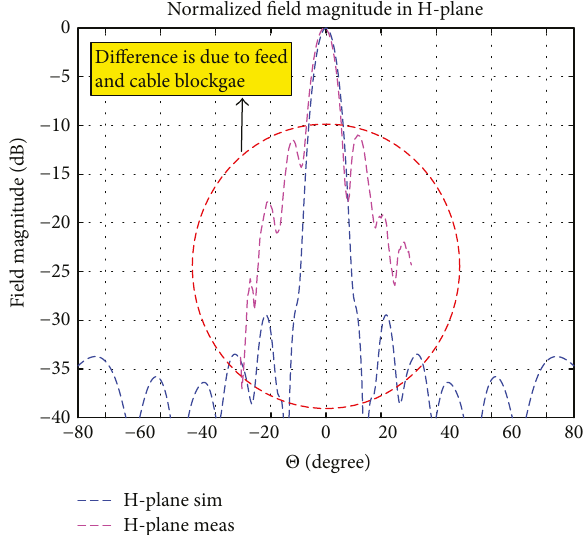
Figure 12: Simulated and measured H-plane radiation patterns from the proposed 3D printed re fl ector antenna at 30GHz.